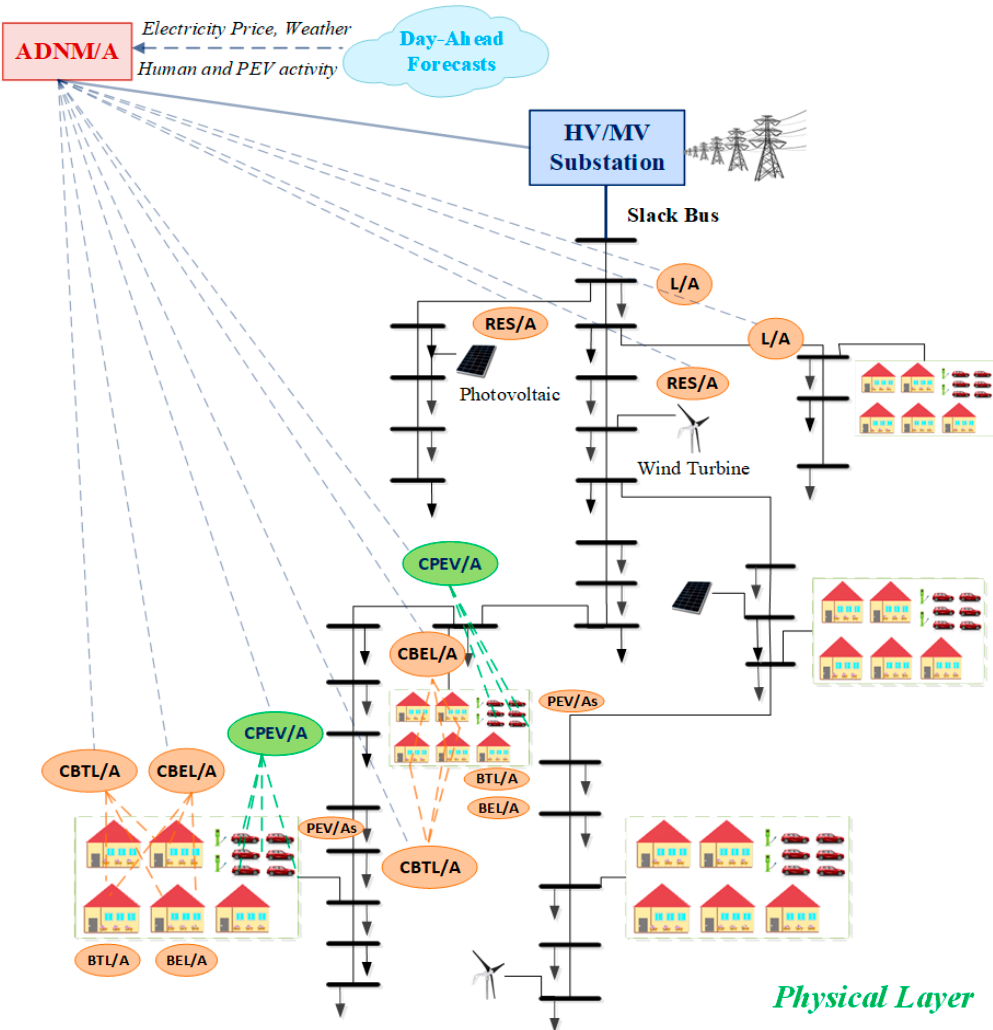
Figure 1. MAS based power management system structure for the active distribution network.